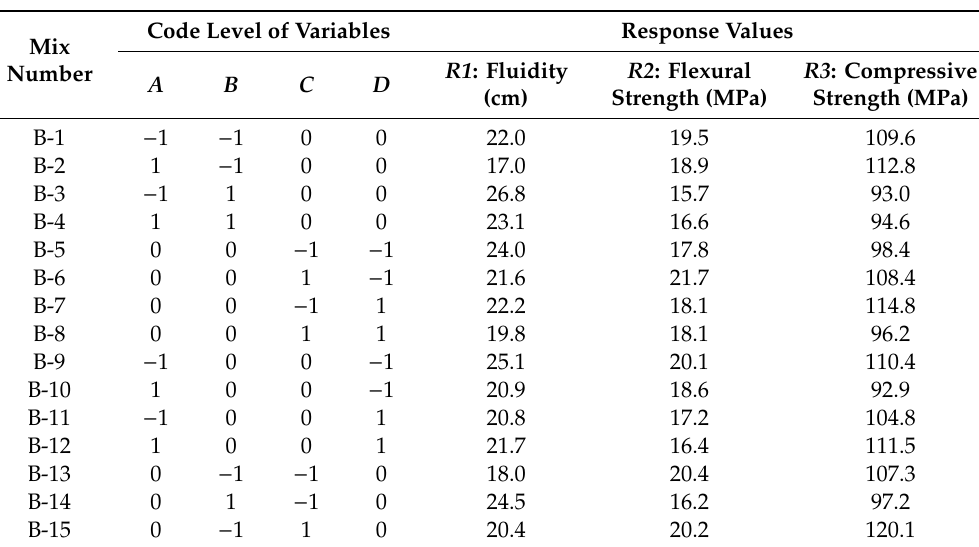
Table 6. Experimental factors and response results of the BBD matrix design.